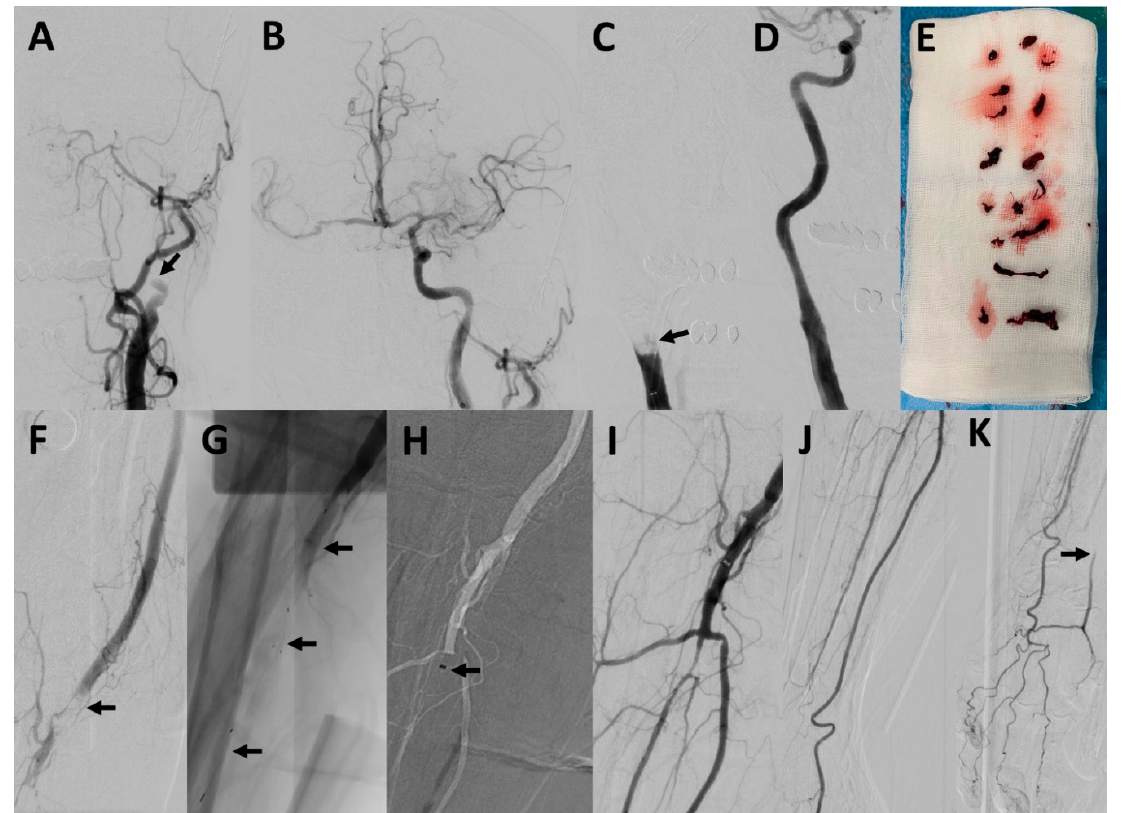
Figure 1. Mechanical thrombectomy of concomitant occlusions of the internal carotid artery, common carotid artery and brachial artery. Patient #2 presented with a left-sided occlusion of the internal carotid artery (( A ), arrow), a right-sided occlusion of the common carotid artery (( C ), arrow) and an occlusion of the right brachial artery ( F , arrow). An occlusion of the V2-segment of the left vertebral artery was also present (not shown) but was not recanalized. After successful recanalization of the left internal carotid artery using direct aspiration ( B ); with only poor collateralization of the territory of the right internal carotid artery) and of the right common carotid artery using aspiration, balloon dilatation and stenting ( D ), harboring a lot of thrombus material ( E ), the right upper limb occlusion was targeted. The brachial artery could be recanalized using one stent retriever maneuver (Neva-T stent retriever marked with arrows in ( G ) and 3 aspiration maneuvers (arrow pointing at the tip of a 6F Sofia aspiration catheter in ( H )). Thrombectomy of the brachial artery was technically successful ( I ), also harboring several large thrombi ( E ). The radial artery could not be completely recanalized, but was filled retrogradely ( J , K ).